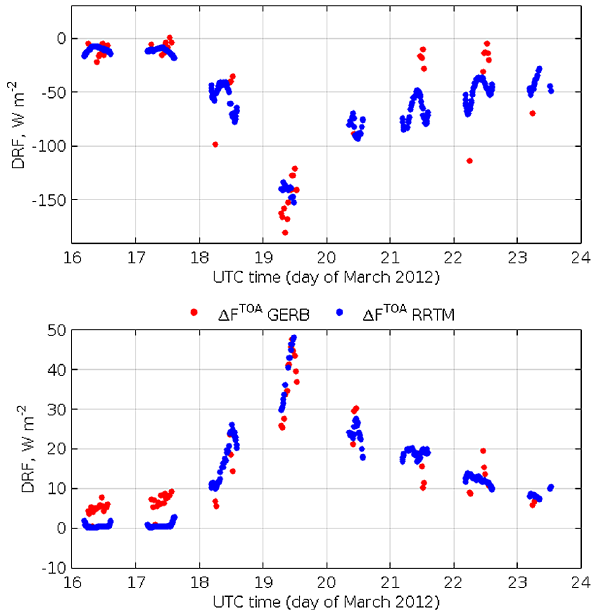
Figure 9. SW (top panel) and LW (bottom panel) TOA DRF at KAUST derived from the model (RRTM, blue) and satellite retrieval (GERB, red).